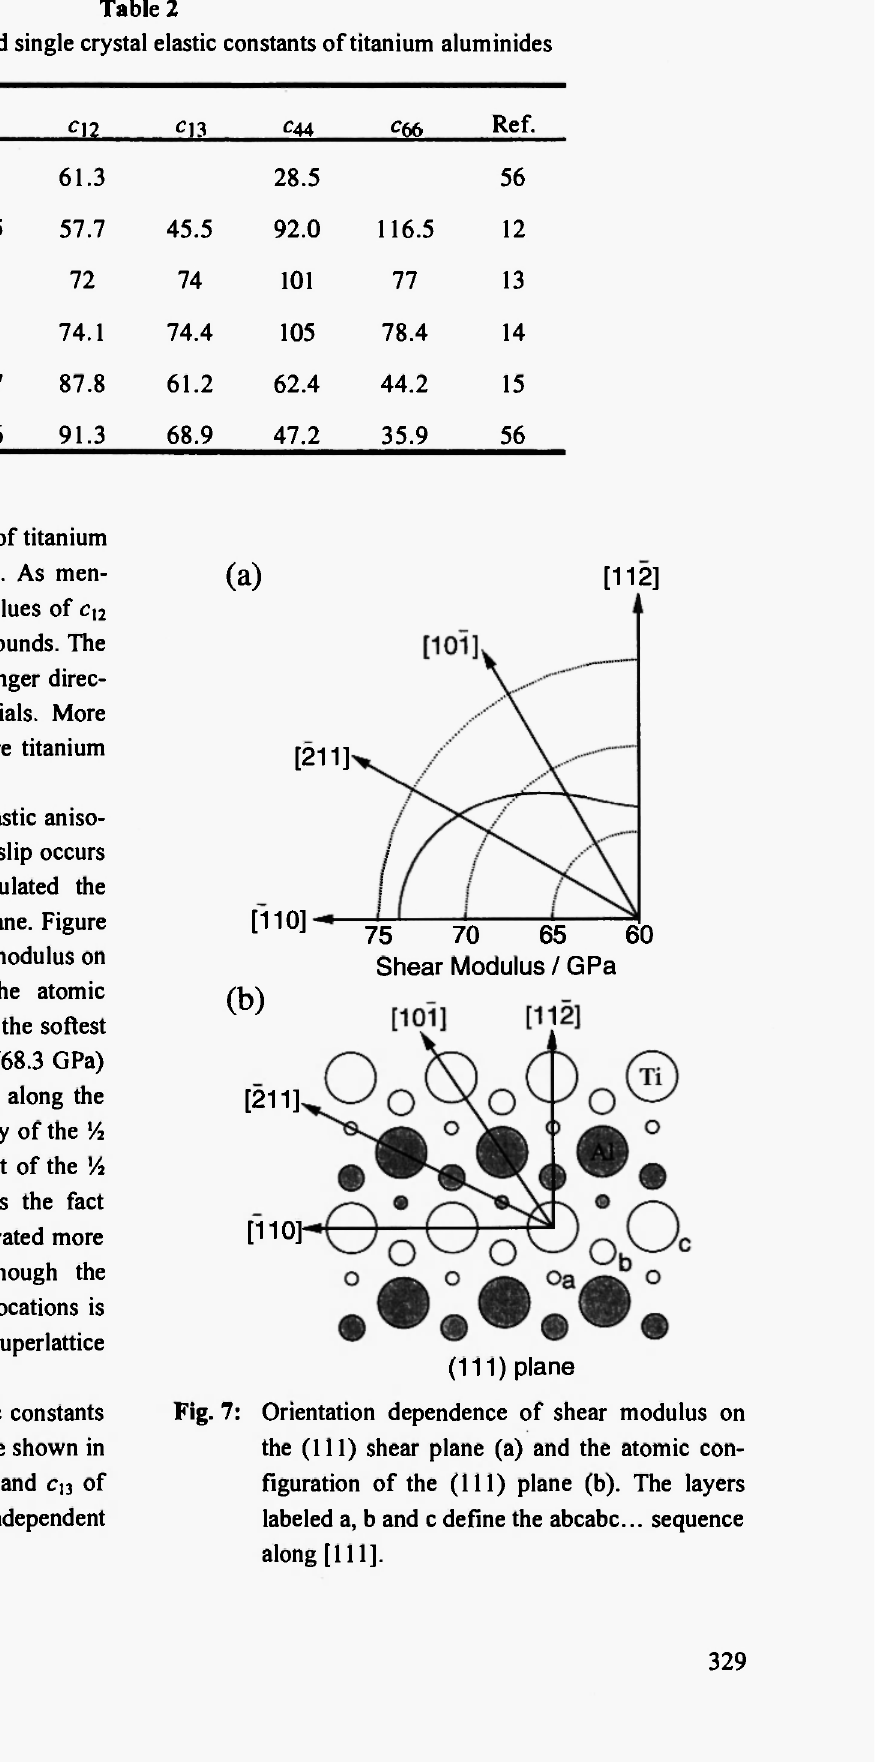
Fig. 7: Orientation dependence of shear modulus on the (111) shear plane (a) and the atomic con- figuration of the (111) plane (b). The layers labeled a, b and c define the abcabc... sequence along [111].